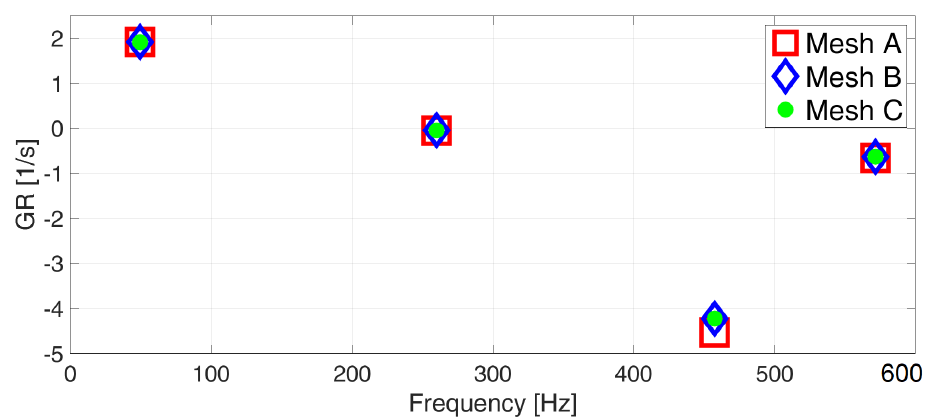
Figure 16. Comparison between the eigenmodes obtained by using different mesh refinements in COM-